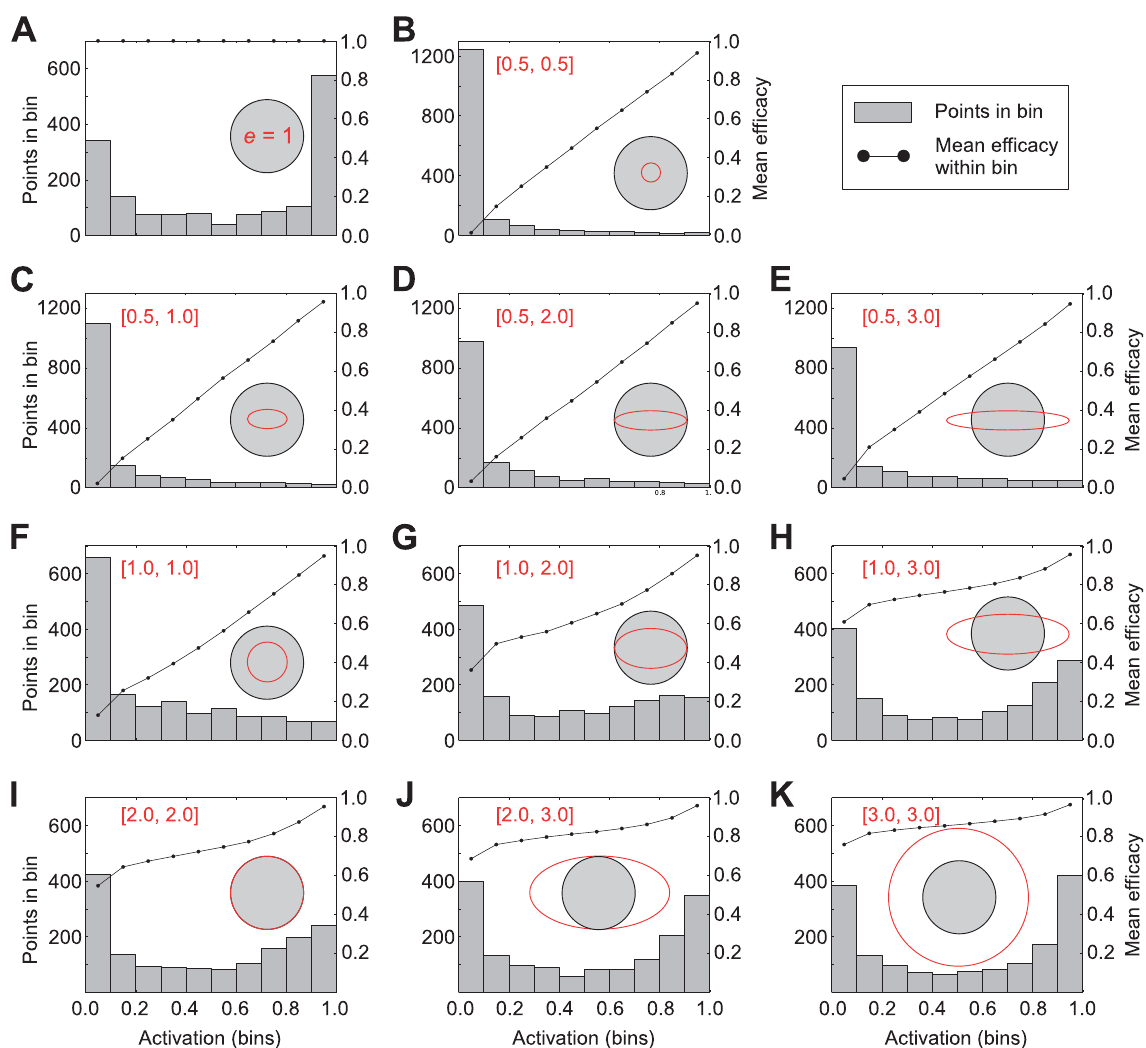
Fig 2. Depictions of the joint effects of receptor affinity and efficacy Gaussians on receptor activation. In each panel, a single receptor is deployed into the center of a two-dimensional [4,4] Q-space. The affinity Gaussian standard deviation ( grey shaded circle ) is uniformly 2.0 q- units in all cases, whereas the standard deviations of the efficacy Gaussian are systematically varied between 1.0, 2.0, and 3.0 q-units in each dimension (except in panel A, where efficacy is uniformly 1.0). A single ligand point was systematically varied across these Q-spaces in increments of 0.1 q-units (1600 points total per Q-space). The activation level of the receptor based on each of these 1600 ligands was calculated, and the results displayed as a histogram ( grey bars ; left ordinate). Broader efficacy Gaussians pull the distributions to the right, yielding higher probabilities of stronger receptor activation. Each of the ligand points also corresponded to an efficacy value; these values were averaged among all of the points within each of the ten bins of the histogram and plotted ( black curve ; right ordinate). This reveals, for example, that the weakest activations in panel B are attributable to low efficacy (antagonist ligands), whereas comparably weak activations in panel K are associated with higher efficacy (agonist) interactions and hence their weakness must be attributable to low-affinity interactions (i.e., weak